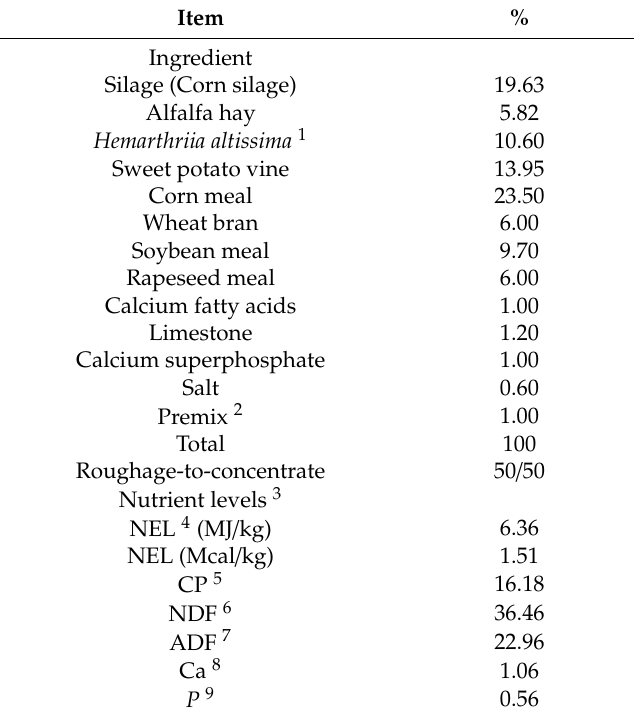
Table 2. Composition (%. of dry matter (DM)) and nutritional value of the diet.